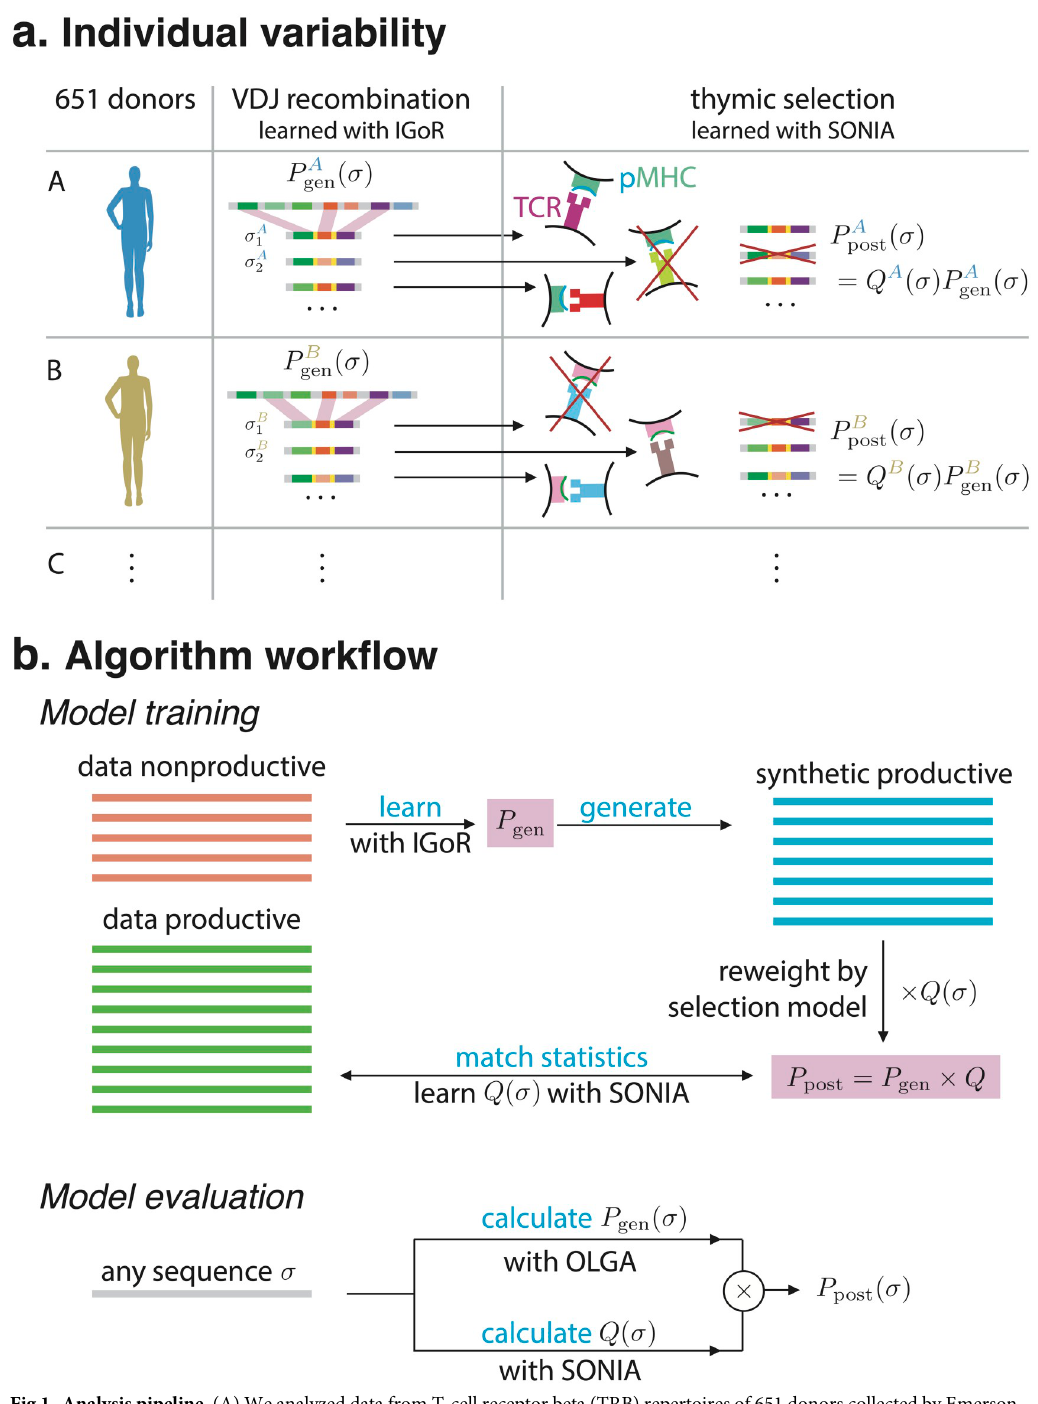
Fig 1. Analysis pipeline. (A) We analyzed data from T-cell receptor beta (TRB) repertoires of 651 donors collected by Emerson et al. [14]. For each person i = A , B , C , ... we define a personalized TRB generation model P i , and a personalized selection gen model Q i ( σ ), as both processes are expected to vary across individuals as a function of their immune history and genetic background, in particular their HLA type for selection. The generation model allows us to evaluate the probability of generating each receptor sequence σ in each individual i . Q i ( σ ) tells us how likely a given receptor amino-acid sequence σ is to pass thymic selection in a given individual. Combined together, the two models give the probability of a given TRB amino acid sequence in the repertoire of a given person P i ð s Þ ¼ Q i ð s Þ P i ð s Þ . (B) To learn these models, for each individual we separated sequences post gen into productive and nonproductive sequences. Nonproductive sequences are free of selection effects and were used to learn the